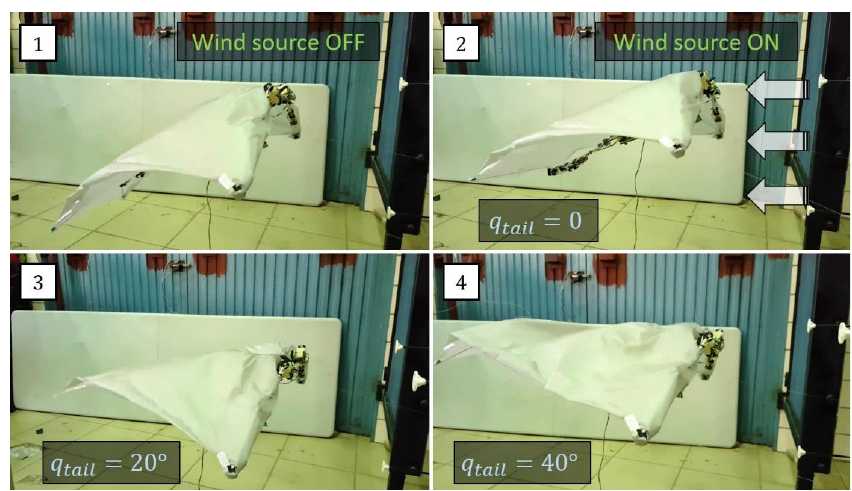
Figure 16. Testbed experiments with wind source, showing the moment in pitch induced by the tail.